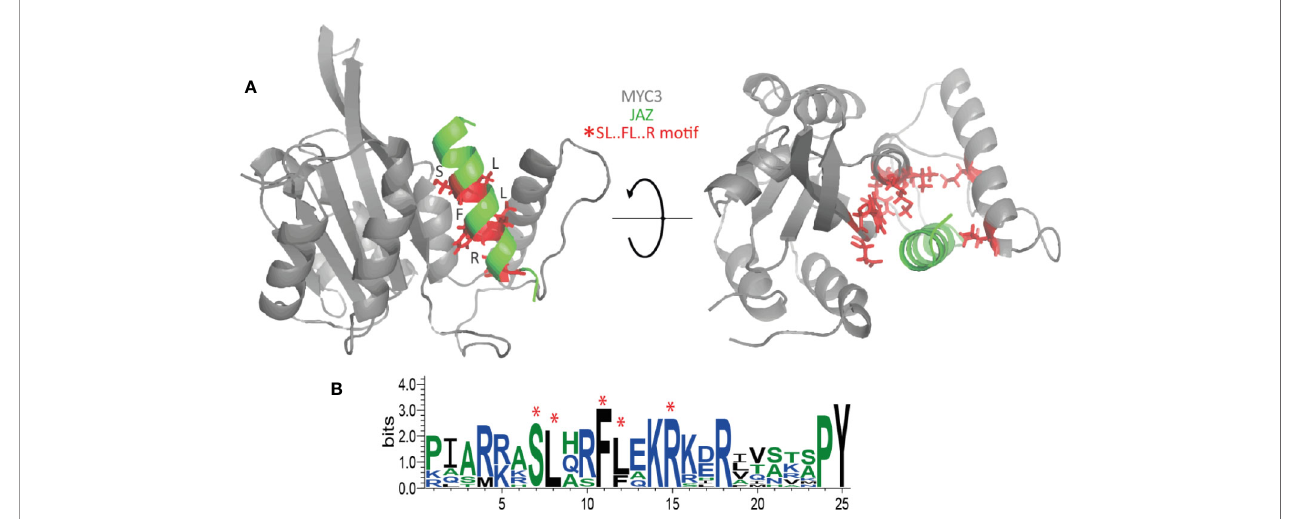
signi fi cant (p<0.05).